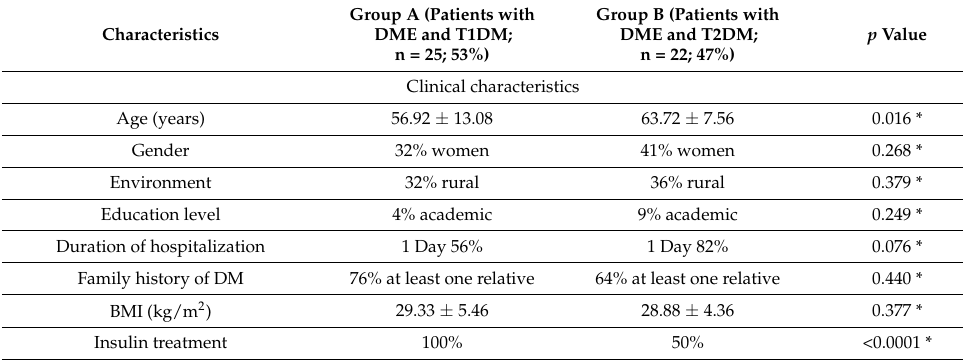
Table 1. Characteristics of patients according to the type of DM.